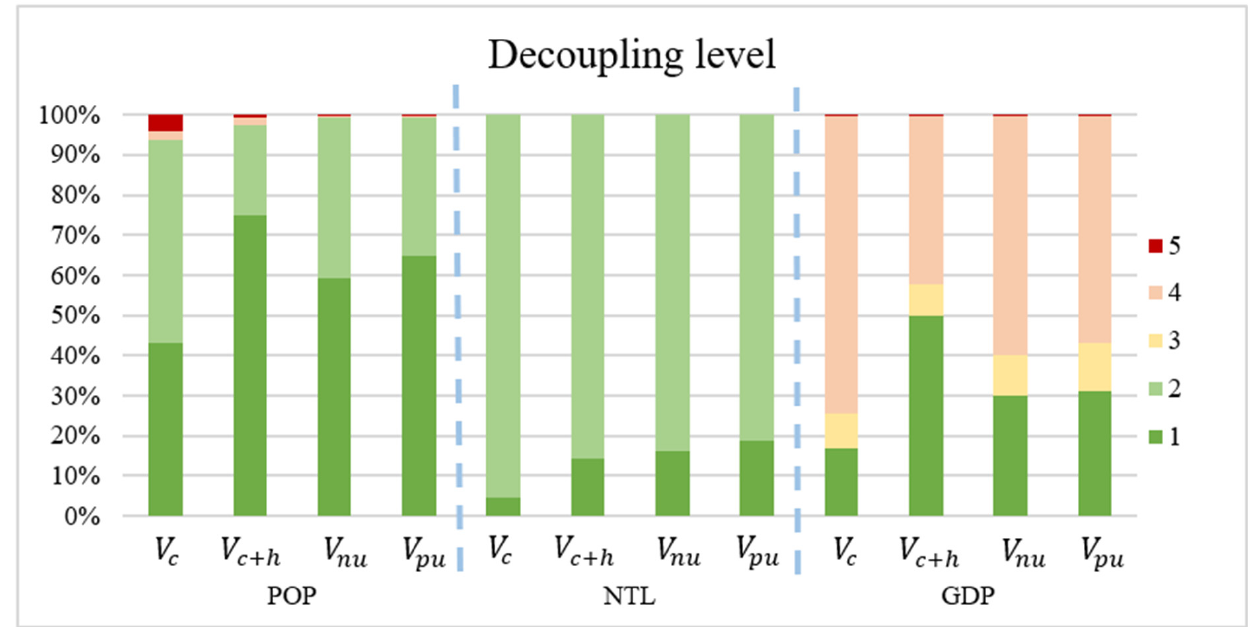
Figure 9. Decoupling level between net primary productivity (NPP) and socioeconomic factors in V c , V c + h , V nu , and V pu